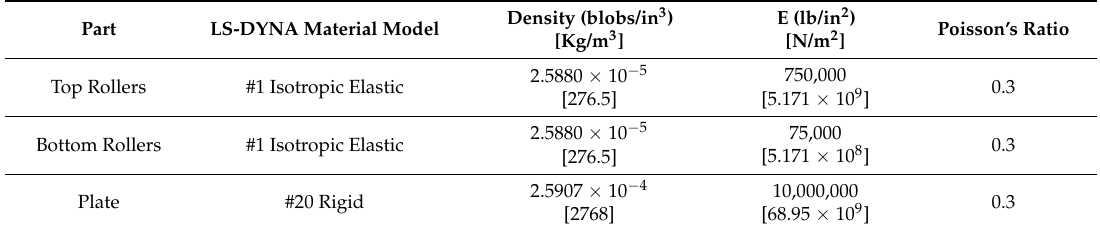
Table 6. ADC roller and aluminum plate material